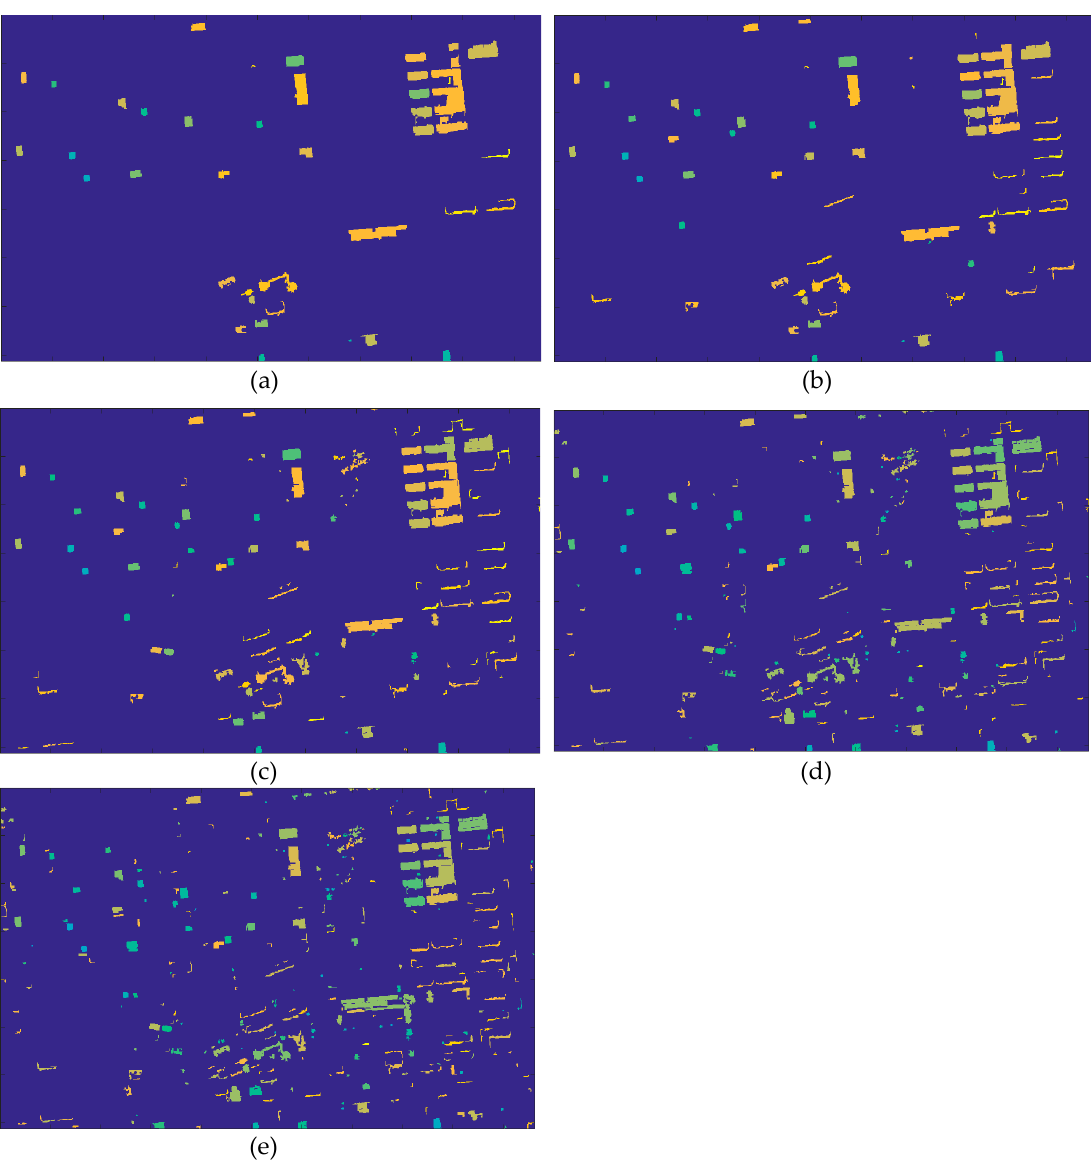
Figure 6. Shape similarity results under segmentation scale: ( a ) Q = 16, ( b ) Q = 32, ( c ) Q = 64, ( d ) Q = 128, and ( e ) Q = 256.